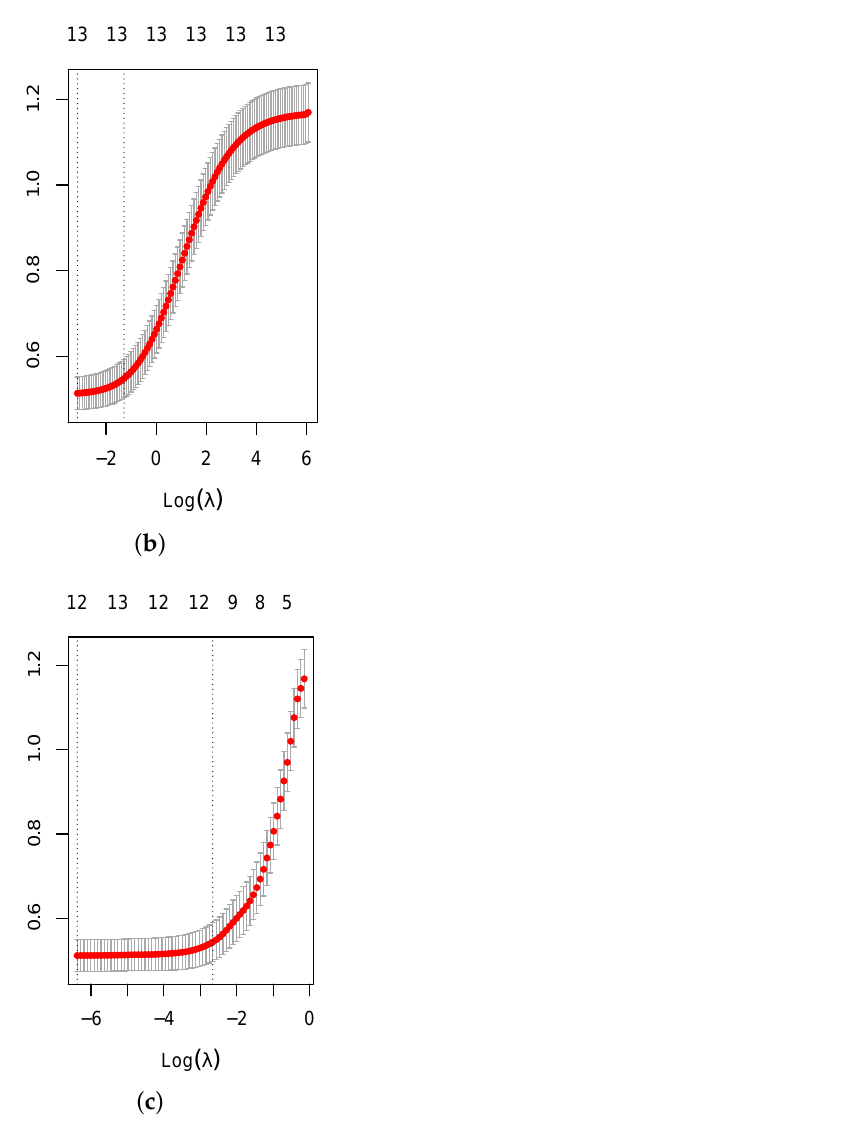
Figure 7. Sample path of tuning parameter λ for the three penalized models. ( a ) Lasso λ path. ( b ) Ridge λ path. ( c ) Net λ